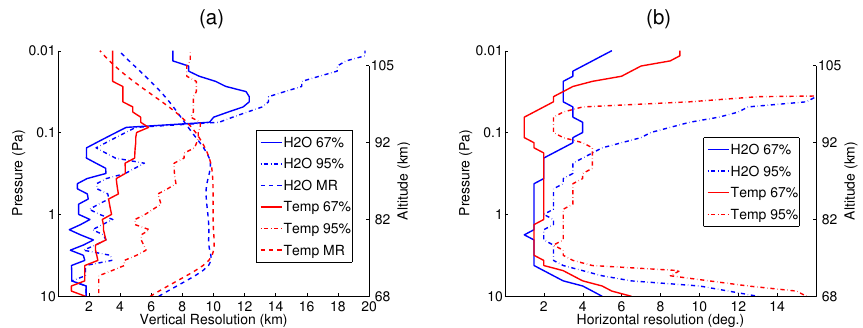
Figure 10. The estimated vertical (a) and horizontal (b) resolution for water vapour (blue) and temperature (red). The solid lines and dash- dotted lines show the resolution calculated using the 67 and 95% quantiles, respectively. The dashed lines in (a) indicate the measurement response multiplied by